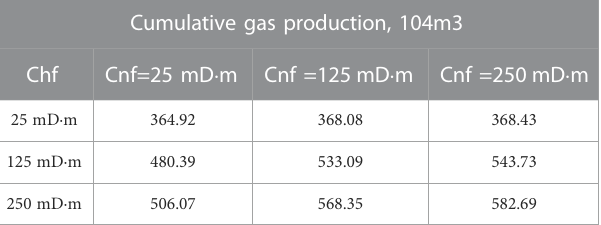
TABLE 3 Comparison of cumulative gas production of a vertical well with different values of hydraulic fracture and natural fracture conductivity. Cumulative gas production, 104m3